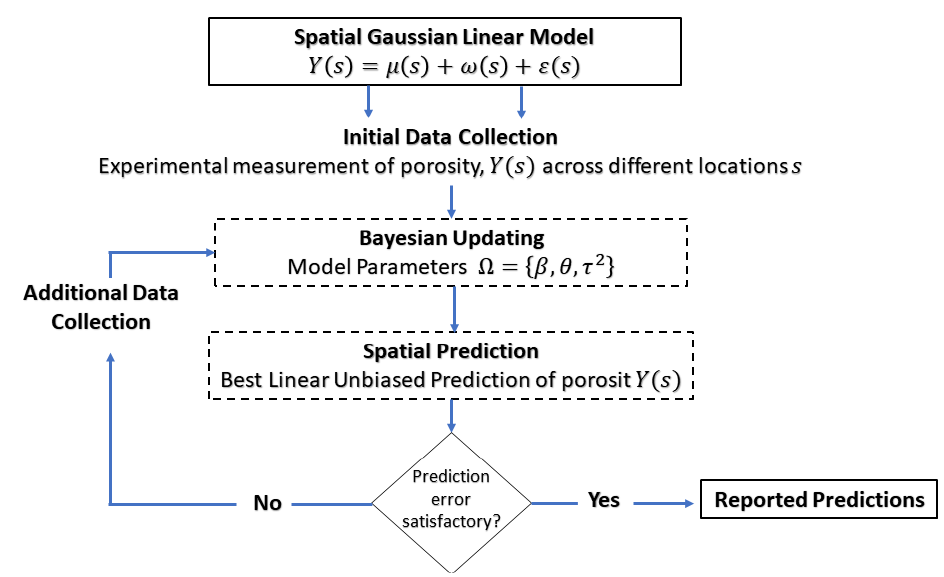
Figure 9. Predictive methodology flow using Spatial Gaussian Linear model.